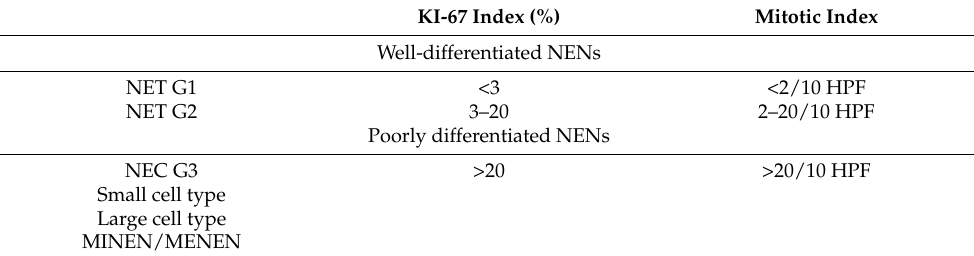
Table 1. Grading of gastrointestinal neuroendocrine tumors by WHO 2017 classification [29].